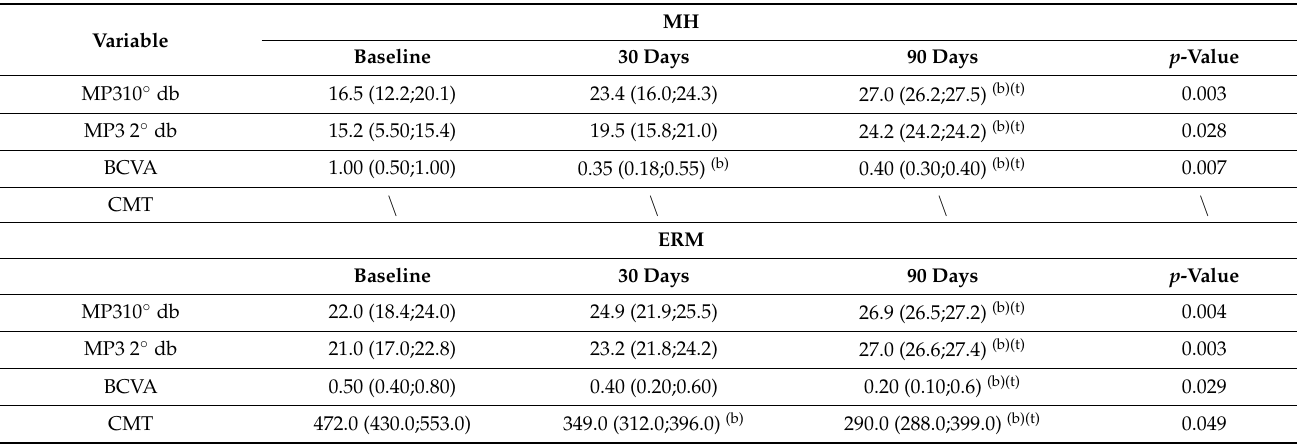
Table 1. Median and quartiles (Q1; Q3) for MH (macular hole) and ERM (epiretinal membrane) reported for baseline and up to 90 days, respectively, for every variable in the study.